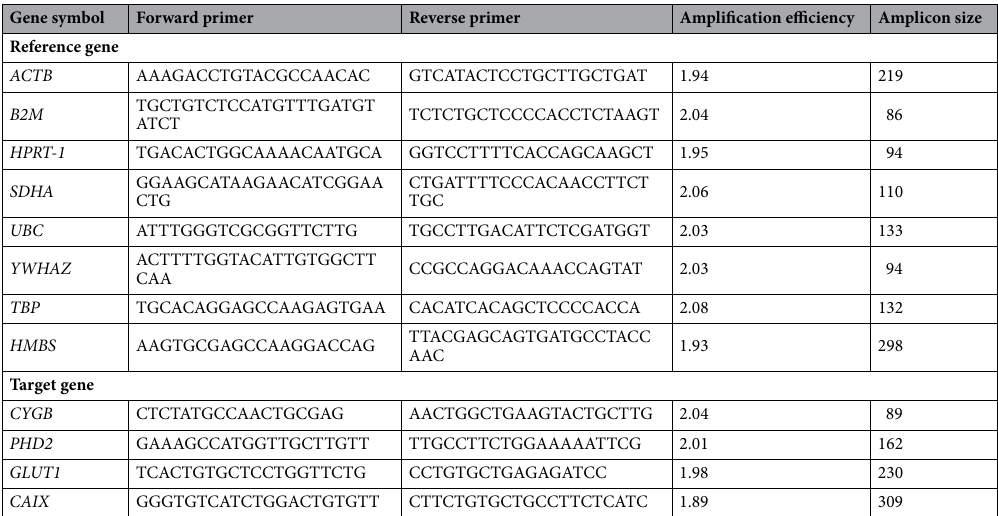
Table 4. Primer sequences, amplification efficiencies and amplicon sizes for candidate normalization genes and target genes. Amplification efficiency is determined using the formula 10 −1/slope . For the actual calculations, the base of the exponential amplification function is used (e.g. 1.94 means 94% amplification efficiency).